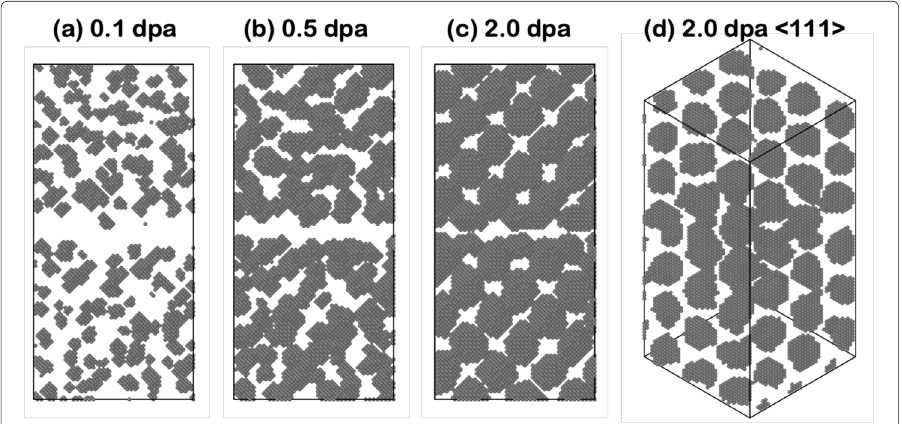
Fig. 5 (Color online) Atomic configurations from an AKMC simulations in bcc Mo at 773 K with a dose rate of 10 − 3 dpa/s. A planar sink is introduced at the middle of the Z direction. The doses level is 0.1, 0.5 and 2.0 dpa in ( a ), ( b ) and ( c ). In ( d ) the configuration at 2.0 dpa is tilted to along the (cid:5) 111 (cid:6) direction. The simulation cell size is 40 × 40 × 80 a 3